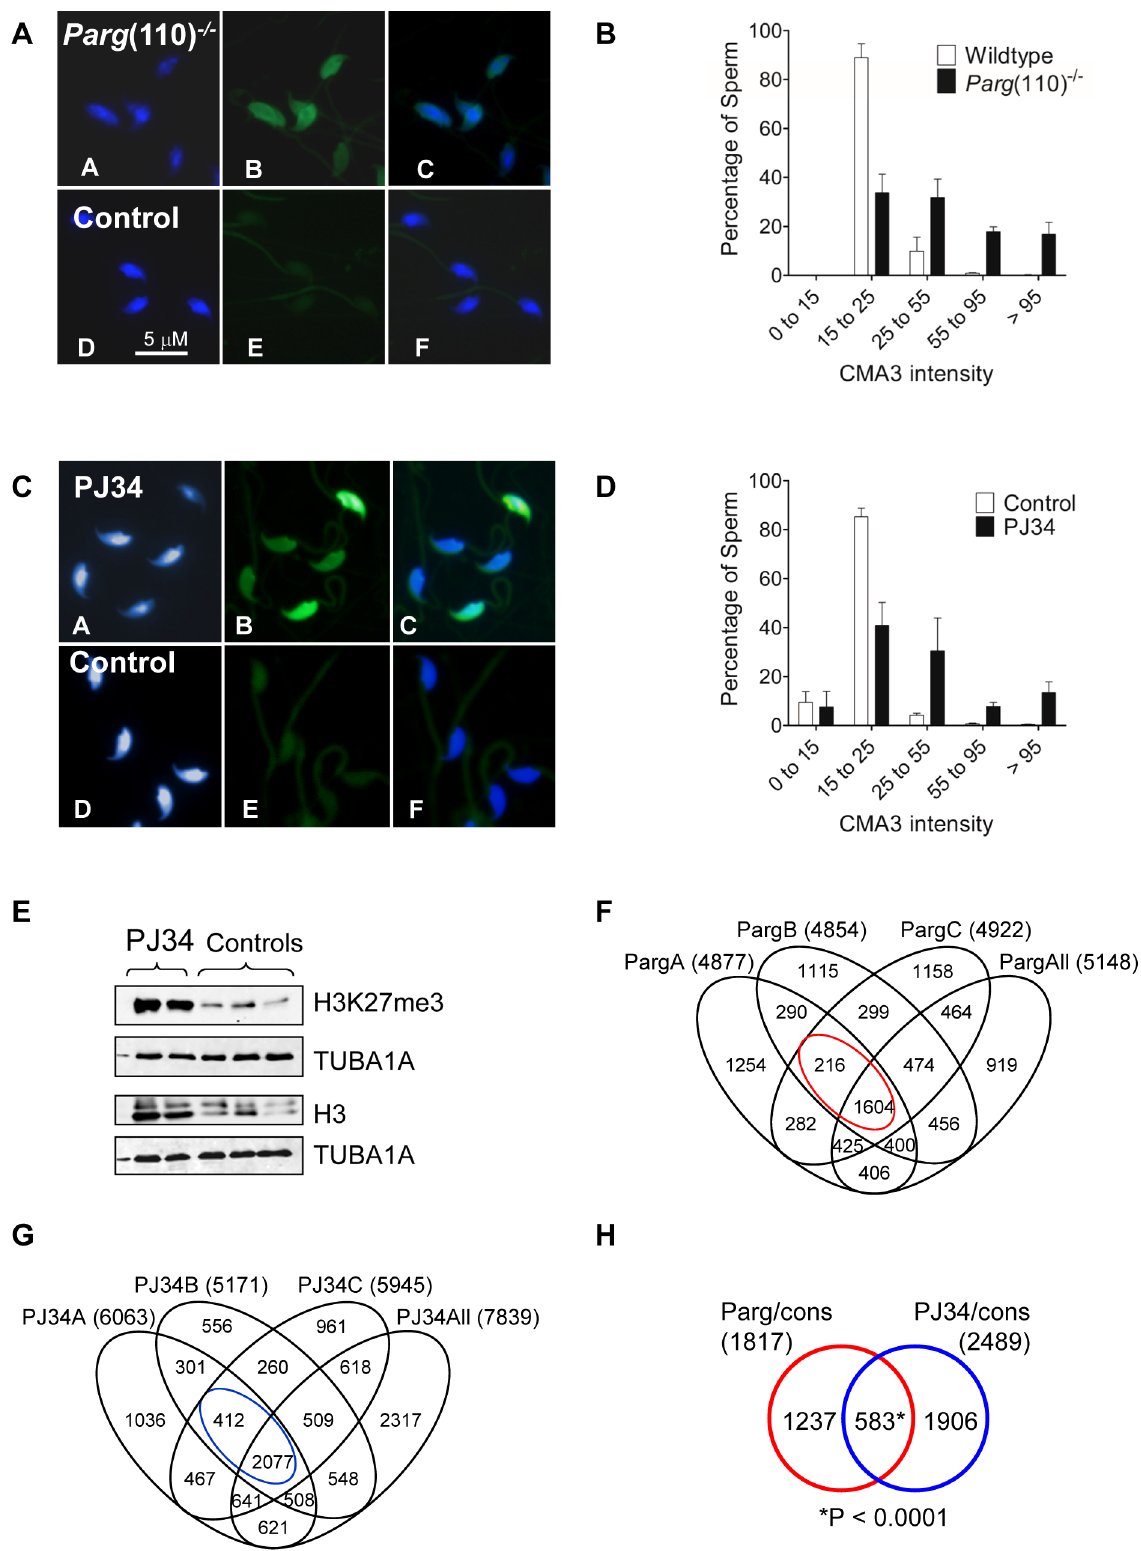
Figure 2. Aberrant chromatin composition in mouse models of altered PAR metabolism. Chromomycin A3 (CMA3) intercalation into the DNA indicates incomplete chromatin condensation in s perm from Parg (110) 2 / 2 (A) and PJ34-treated (C) males with histone retention. (B, D) Histogram of sperm CMA3-staining intensities reflects that severity of CM3A staining varied at the level of individual sperm and individual fathers (n . 200 nuclei/sample, 3 males/group). (E) Immunoblot analyses of sperm protein lysates showing increase in histone retention in PJ34 treated males.